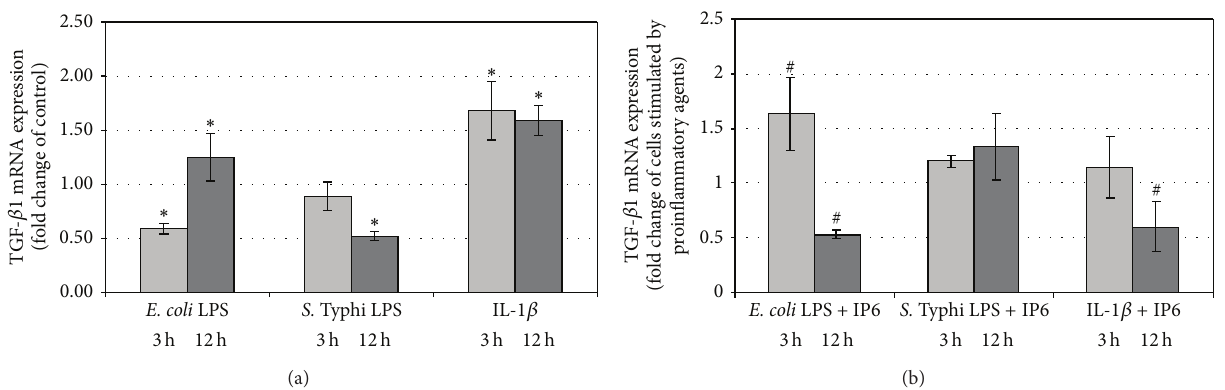
Figure 1: Expression of TGF- 𝛽 1 gene in Caco-2 cells as determined by real-time RT-PCR. Changes in TGF- 𝛽 1 mRNA expression in Caco- 2 cells after treatment with (a) proinflammatory agents and (b) proinflammatory agents and 2.5mM IP6 for 3 h and 12h. The results are presented as mean ± SD of three separate experiments; ∗ 𝑃 < 0.05 versus control Caco-2 cells; # 𝑃 < 0.05 versus proinflammatory agents- stimulated cells.